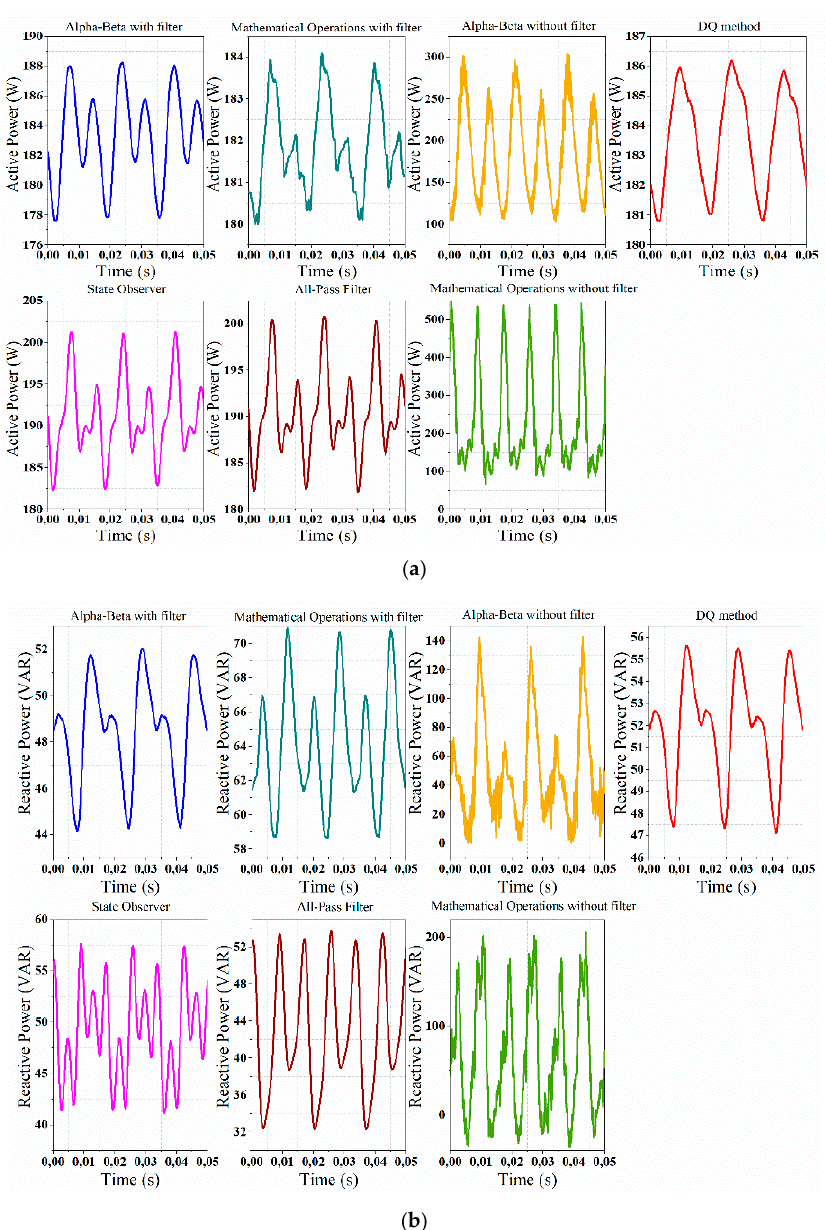
Figure 12. Power calculation at fundamental frequency + 3rd harmonic: ( a ) active power; ( b ) reactive power.